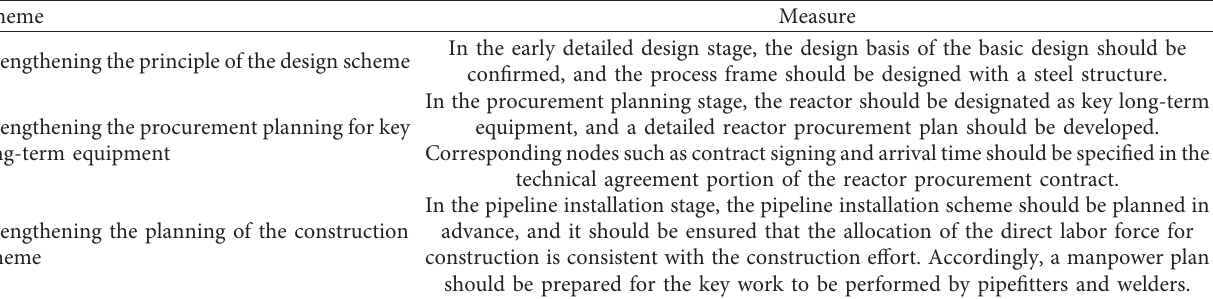
Table 10: Preventive measures.